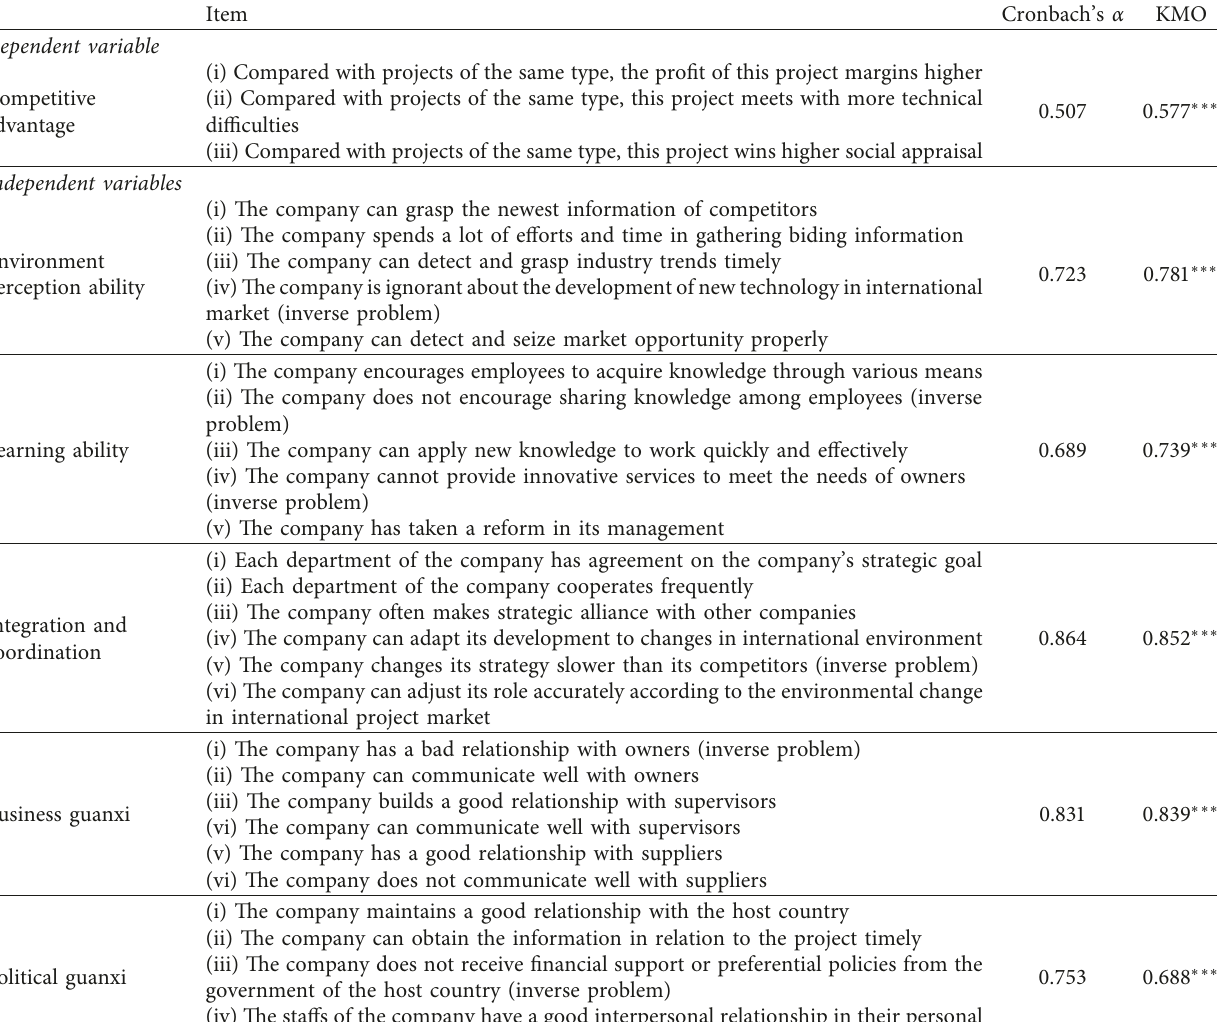
Table 2: Measurement of